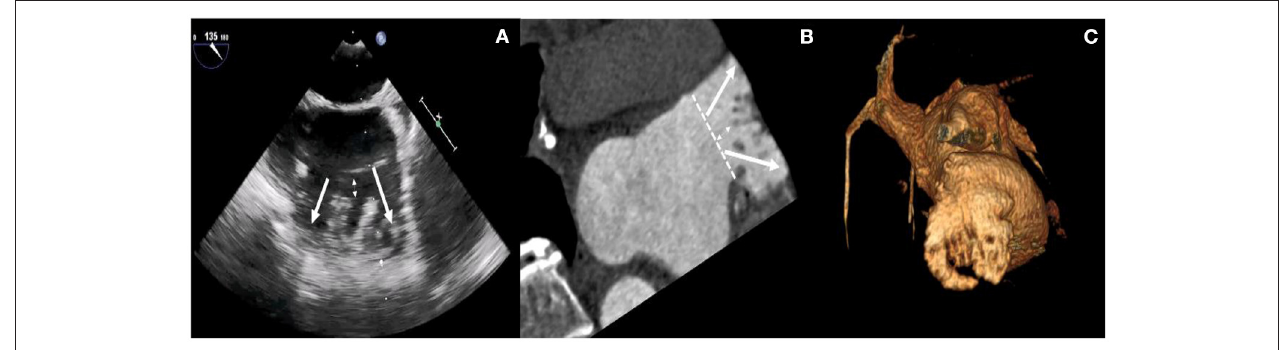
FIGURE 1 | Higher degrees of 2D TEE and CCTA images. TEE views at 120 ◦ (A) reveal the presence of two main lobes with short common distances to the common ostium, a great diameter of ostium, and pectinate muscles that separated the LAA into multiple lobes (white arrows). Multiplanar reconstruction (B) and volume-rendering computed tomography (CT) image (C) provide an overview of the anatomy of LAA lobes and pectinate